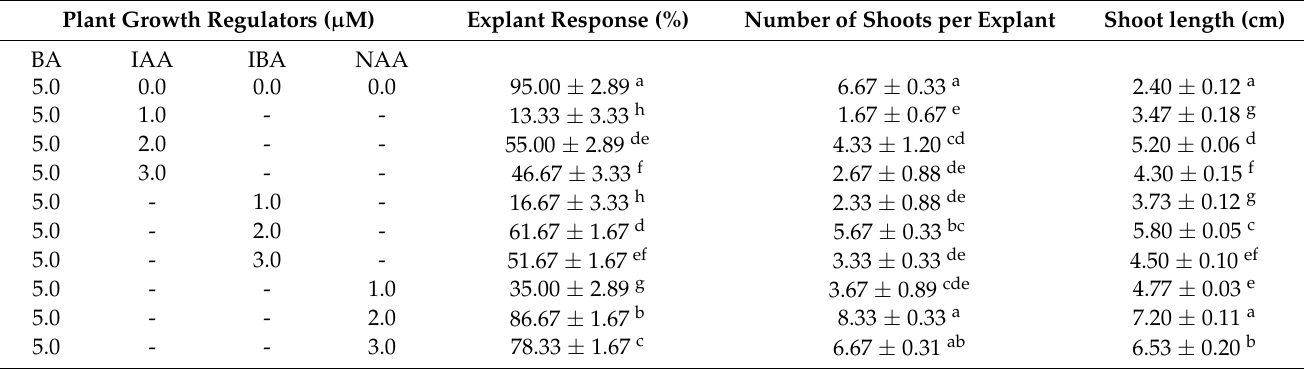
Table 2. Effect of auxin with BA (5 µ M) on shoot multiplication of D. palmatus after six weeks. Plant Growth Regulators ( µ M) Explant Response